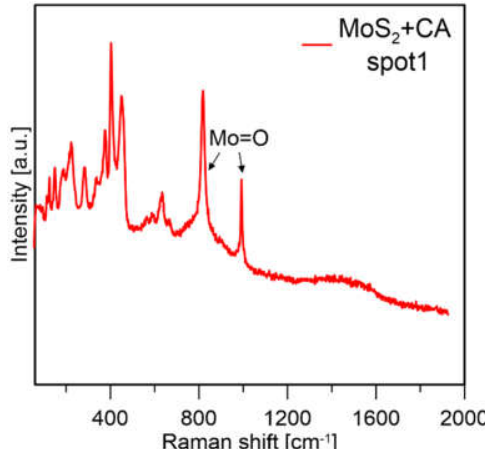
Figure 12. Raman spectra of MoS 2 prepared with CA and FA at 1% laser power.